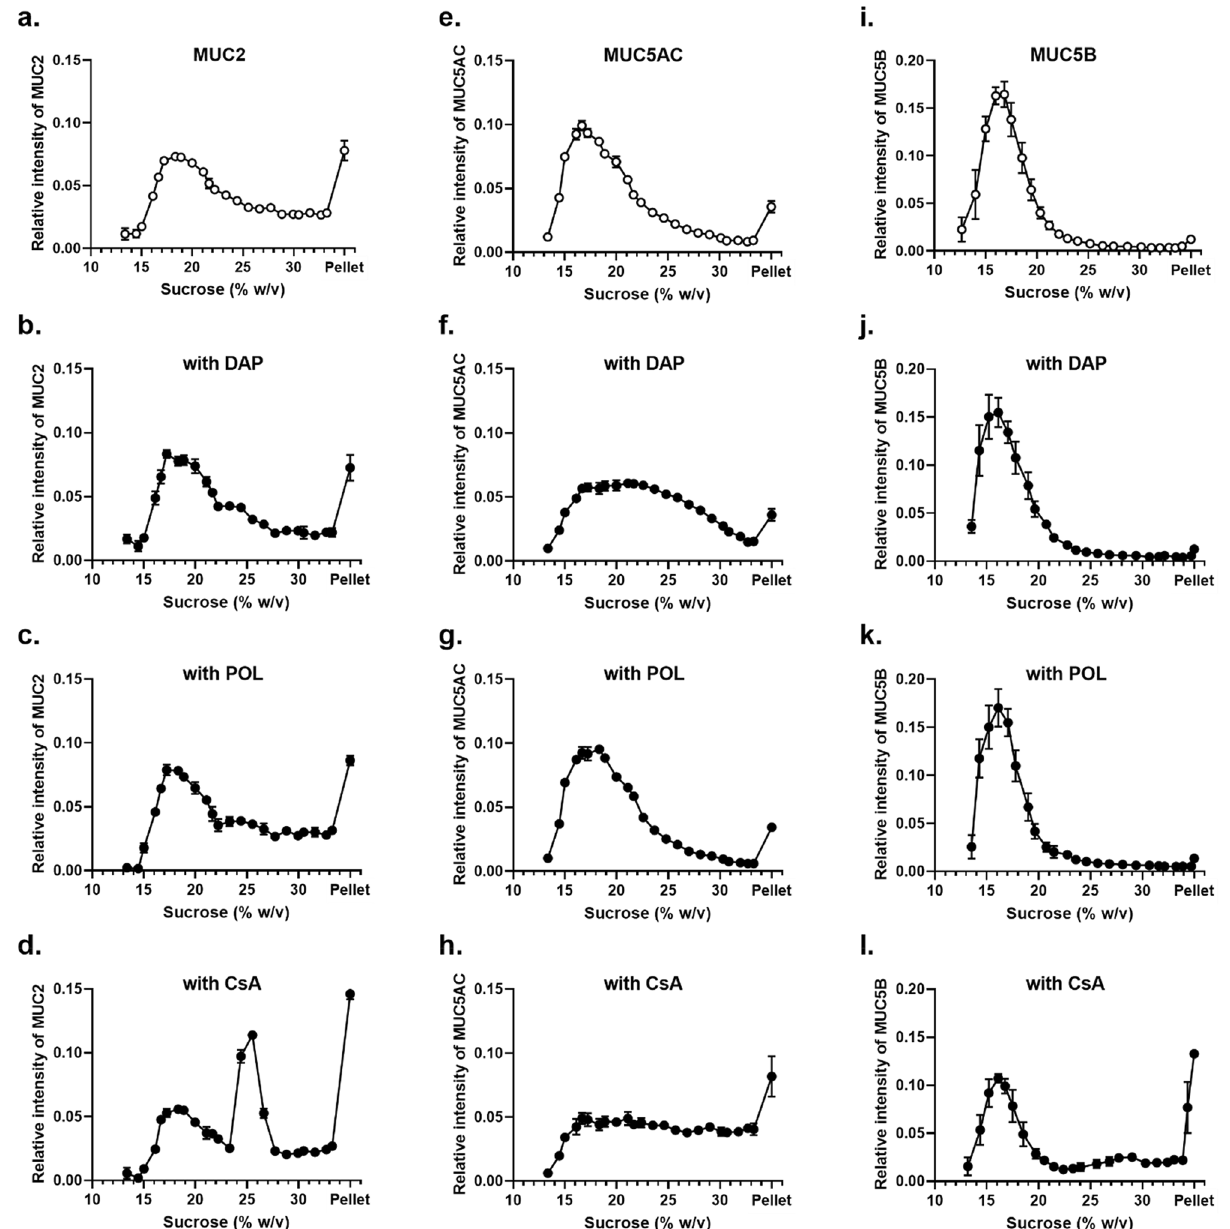
Figure 1. Sedimentation profiles of purified gel-forming mucins in the presence of cyclic peptide. Rate-zonal centrifugation in 10–35% (w/v) sucrose gradients of purified MUC2 ( a – d ), MUC5AC ( e – h ), and MUC5B (i– l ), untreated ( a , e , i ), with 1 mM DAP ( b , f , j ), with POL ( c , g , k ), or with CsA ( d , h , l ). Mucins were detected in sucrose gradient fractions after slot blotting by PAS staining (MUC2; a – d ) or the mucin-specific antibody probes, MAN-5ACI ( e – h ), and EUMUC5B ( i – l ). Band intensities were quantified using the Odyssey Imaging system. The results are presented as the mean ± s.e.m. (n = 3–5) from 3 independent